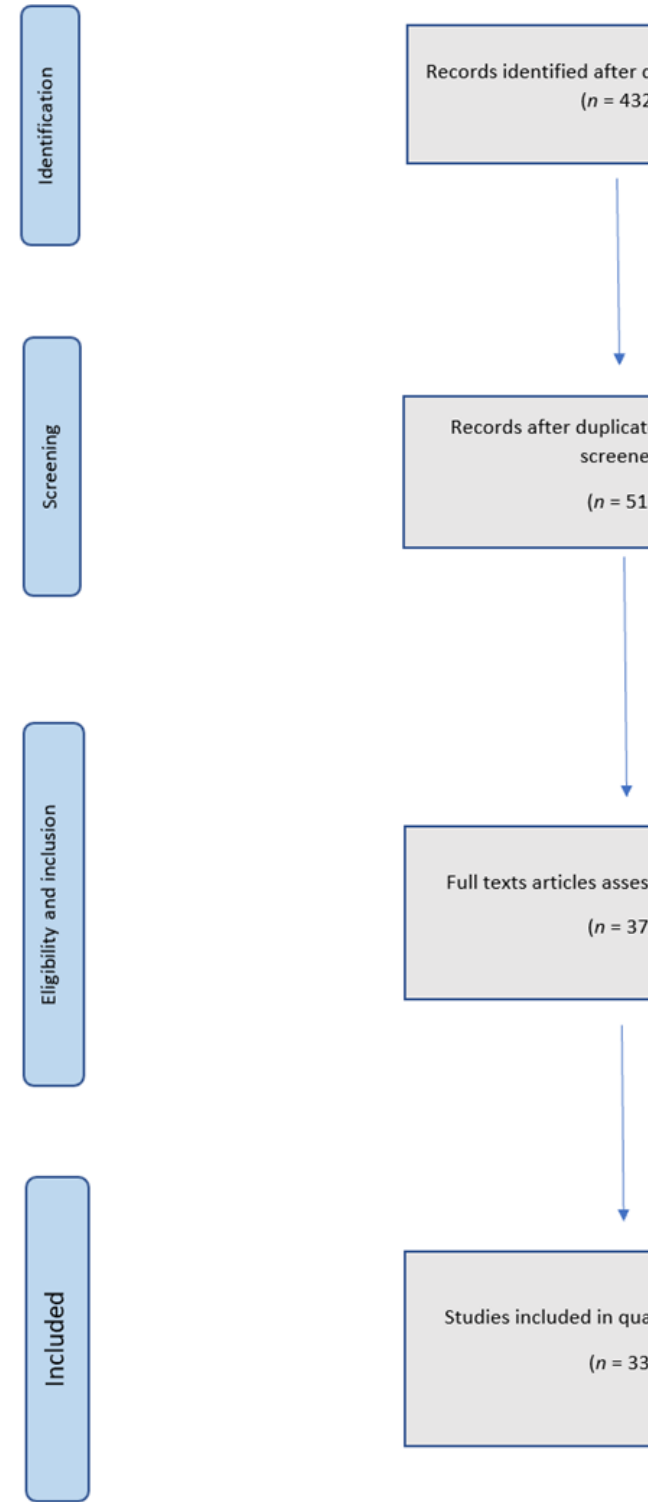
Figure 1. Flow chart of inclusion and selection.